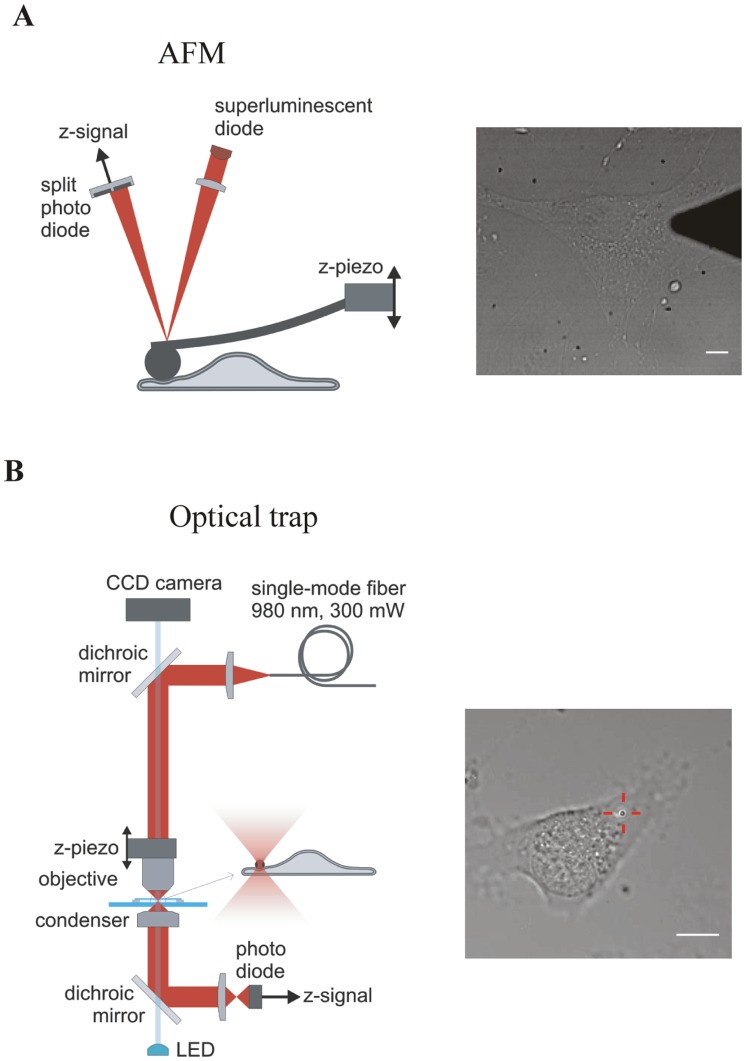
Experimental setups to measure the cell response in vertical direction. A)AFM: The cantilever is moved up and down with the z-piezo. When the AFM tip touches and indents the cell, the cantilever will bend. The amount of bending is measured via a laser beam that is reflected onto a split photodiode. Its electrical signal is linear proportional with the applied force on the cell. B) Optical trap: A laser beam, emitted from a single mode fibre, is coupled into the optical path of a standard upright microscope via a dichroic mirror and focused into the sample by the objective. The vertical position of the trap is controlled by a z-piezo that moves the objective up and down. The inset figure shows a bead that is trapped in the focus, and pushed into a cell. To monitor the displacement of the bead from the centre of the trap, the laser light is collected by the condenser, coupled out of the optical path via a second dichroic mirror and cast onto a photodiode. Both scale bars are 10 µm.